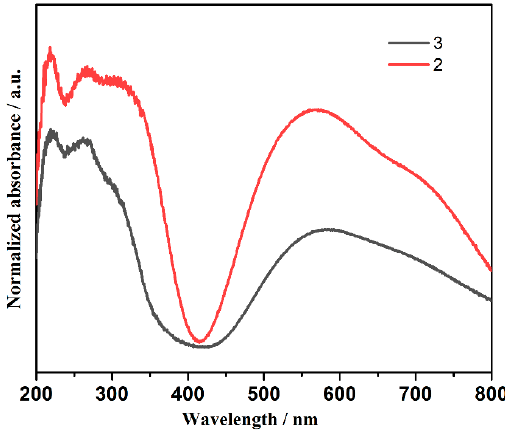
Figure 7. UV-vis absorption spectra of 2 and 3.